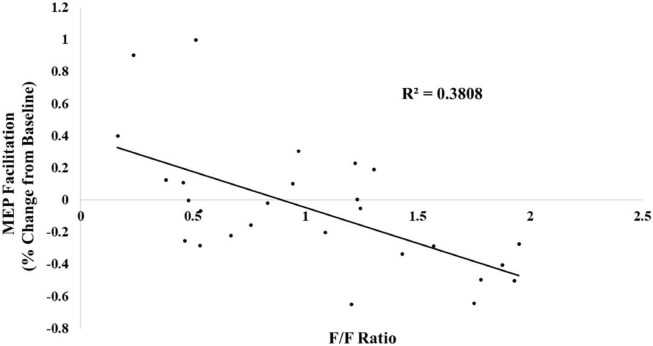
The following/follower ratio was linearly related with MEP facilitation.